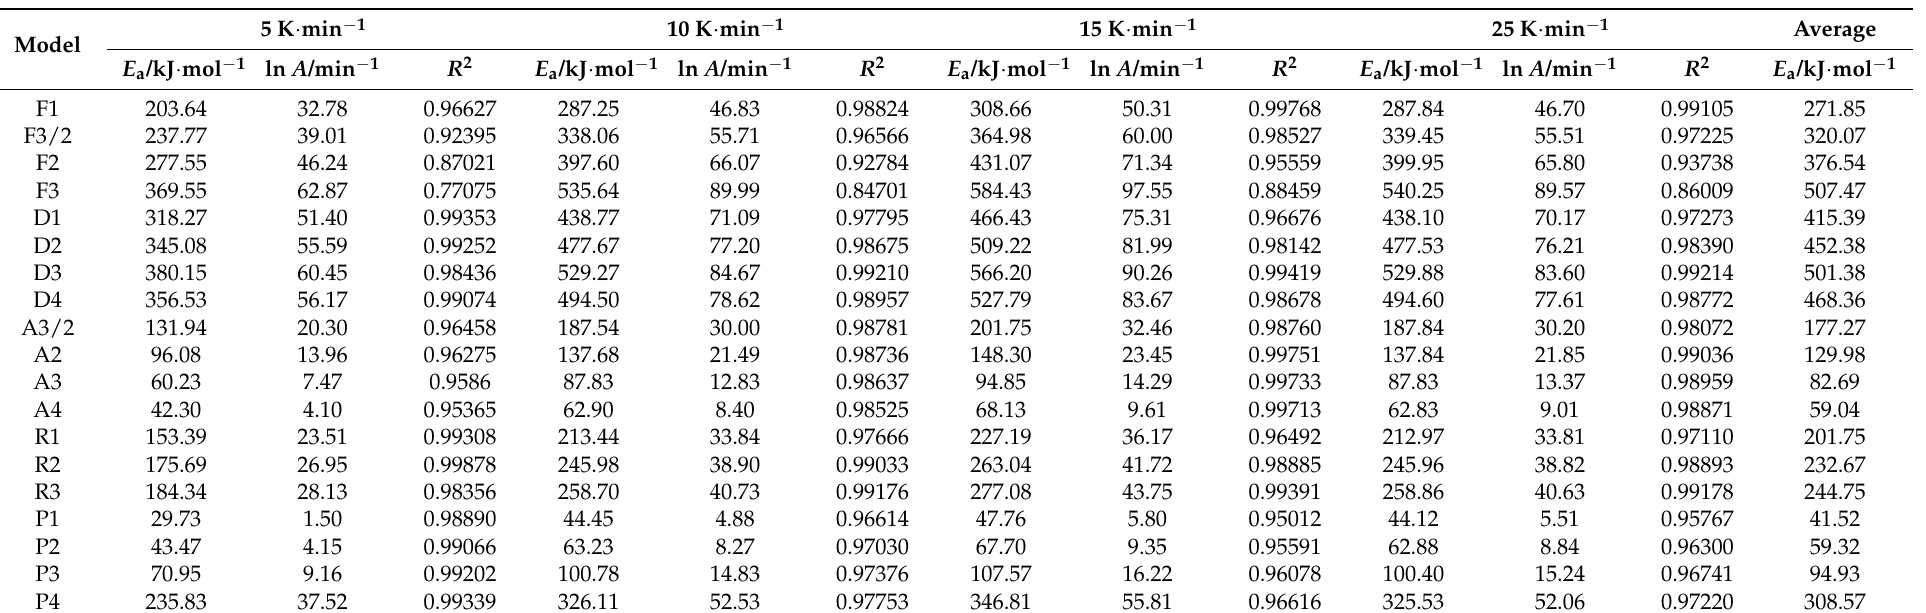
Table A1. The kinetic parameters of IB calculated by CR method at different heating